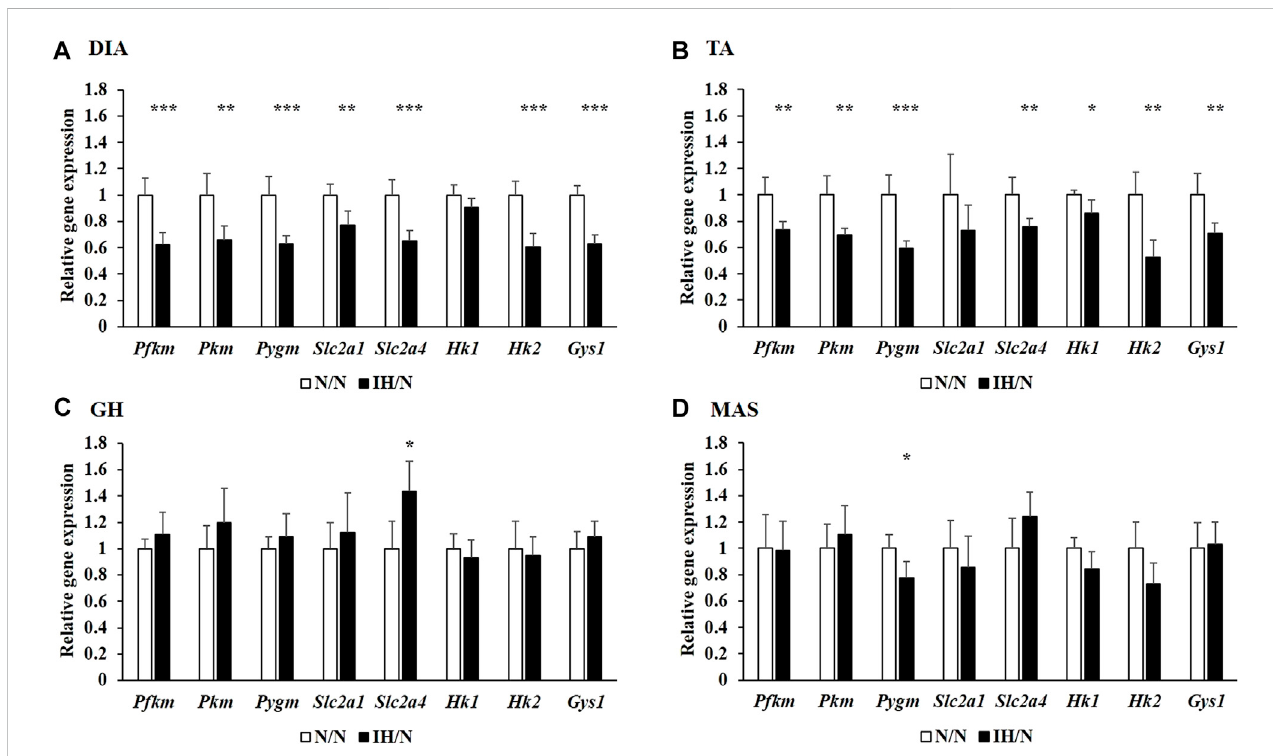
FIGURE 4 Quantitative PCR analysis of genes associated with glucose metabolism. Relative gene expression of Pkfm , Pkm , Pygm , Slc2a1 , Slc2a4 , Hk1 , Hk2 , and Gys1 in the (A) DIA, (B) TA, (C) GH, and (D) MAS muscles werenormalized by Actb and shown as fold increase of the N/N group * p < .05, ** p < .01, *** p < .001.